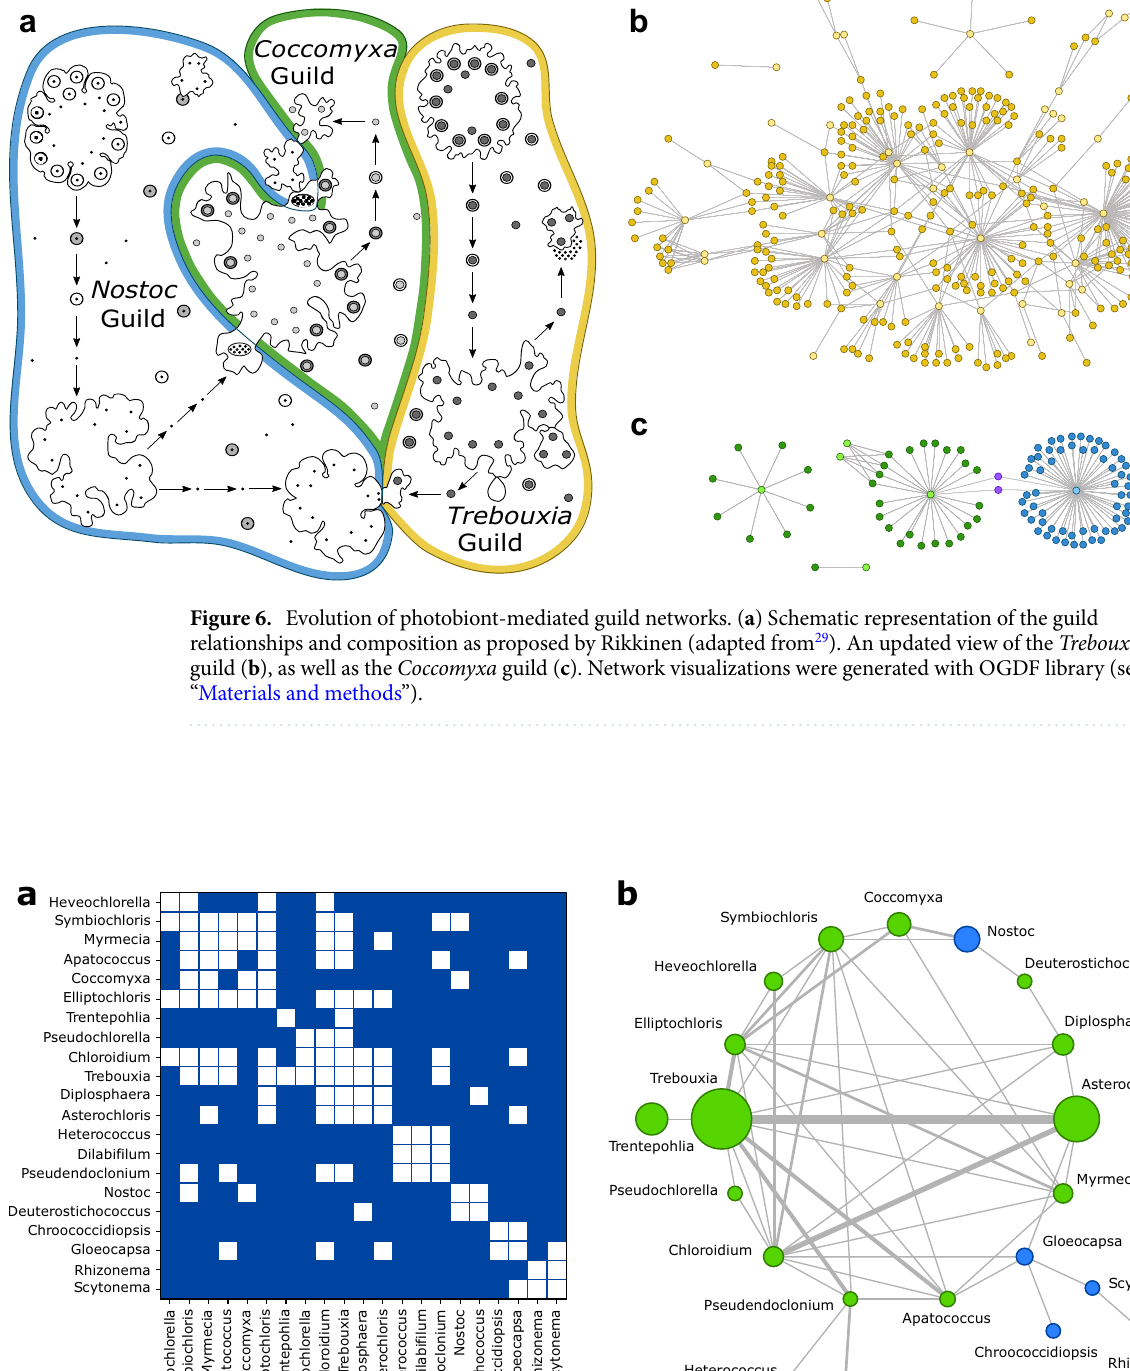
Figure 7. Global connectivity between photobiont genera. Using the photobiont genus as the foundation for lichen guilds, we reconstruct the guild network’s adjacency matrix ( a ), where white squares represent at least one mycobiont shared by photobiont genera. Photobionts are sorted using their pairwise distances and fastcluster algorithm (see “Materials and methods”). In ( b ) we show the corresponding network representation, where link widths are proportional to the amount of shared mycobionts between photobiont genera, node sizes are proportional to the number of species (both photobionts and mycobionts) belonging to that guild and and are colored according to their group: green for green algae ( Chlorophyta and Charophyta ), blue for cyanobacteria and yellow for yellow-green algae ( Xanthophyta ). Network visualizations were generated with OGDF library (see “Materials and